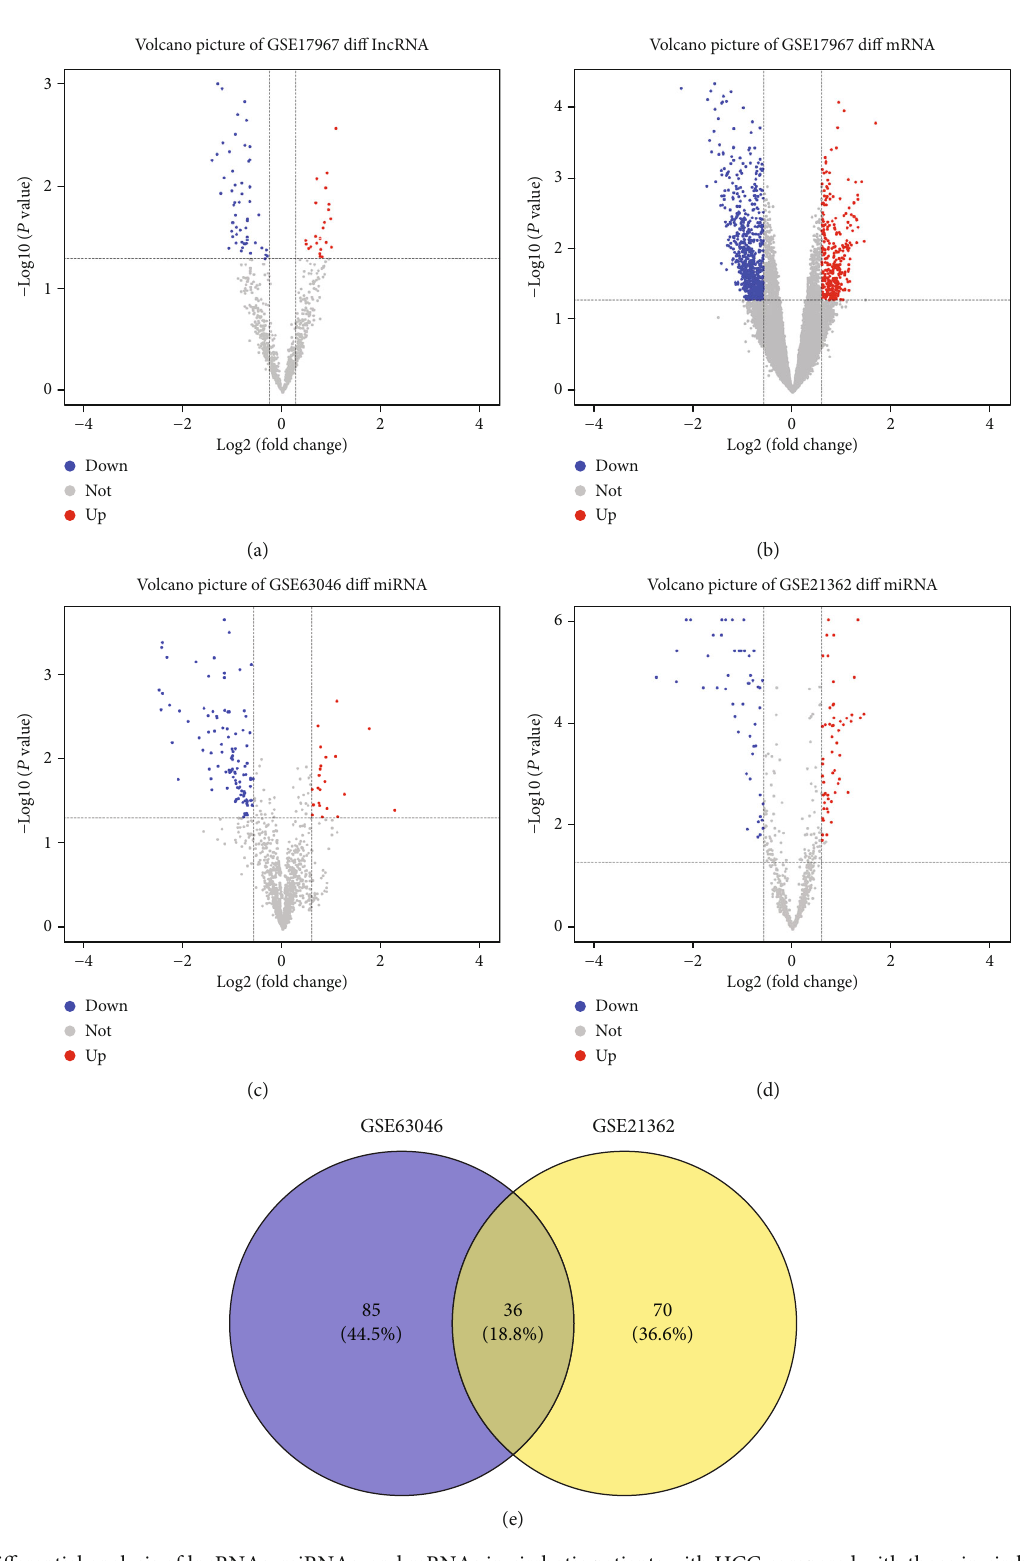
Figure 1: Di ff erential analysis of lncRNAs, miRNAs, and mRNAs in cirrhotic patients with HCC compared with those in cirrhotic patients without HCC ( foldchange > 1 : 2 ; P < 0 : 05 ). (a, b) Volcano picture showing the upregulated (in red), downregulated (in blue), and undi ff erentiated (in gray) lncRNAs and mRNAs in their expression of GSE17967. (c, d) Volcano picture showing the upregulated (in red), downregulated (in blue), and undi ff erentiated (in gray) miRNAs in their expression of GSE63046 and GSE21362. (e) Venn diagram analysis of di ff erentially expressed miRNA obtained from GSE63046 and GSE21362. The number in the overlapping portion indicates the common miRNAs. lncRNA: long noncoding RNA; miRNA: microRNA; mRNA: messenger RNA; HCC: hepatocellular